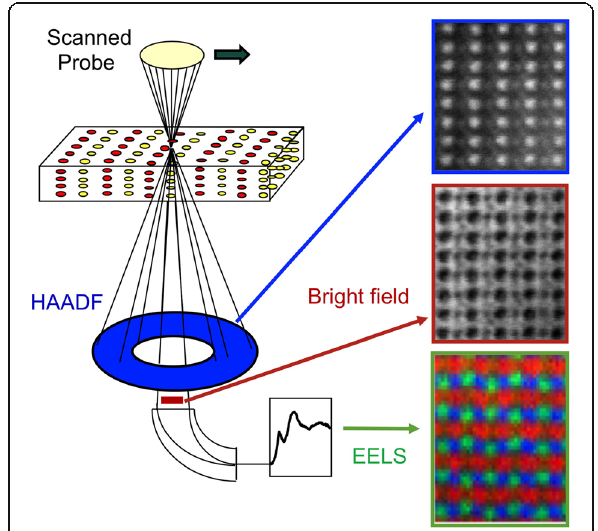
Fig. 1 Schematic showing the multiple imaging and analytical signals available in STEM. Top right is a HAADF image of BiFeO 3 ; the brightest atom columns are Bi and the less bright ones Fe, which are seen displaced slightly to the right due to the ferroelectric polarization. The center image is a bright-field image showing O columns, below is a color composite EELS image of LaMnO 3 in which the Mn is shown in red, O in green, showing displacements due to octahedral rotations, and La in blue. Adapted with premission from Borisevich et al. 2010, copyrighted by the American Physical Society, and Varela et al. 2012